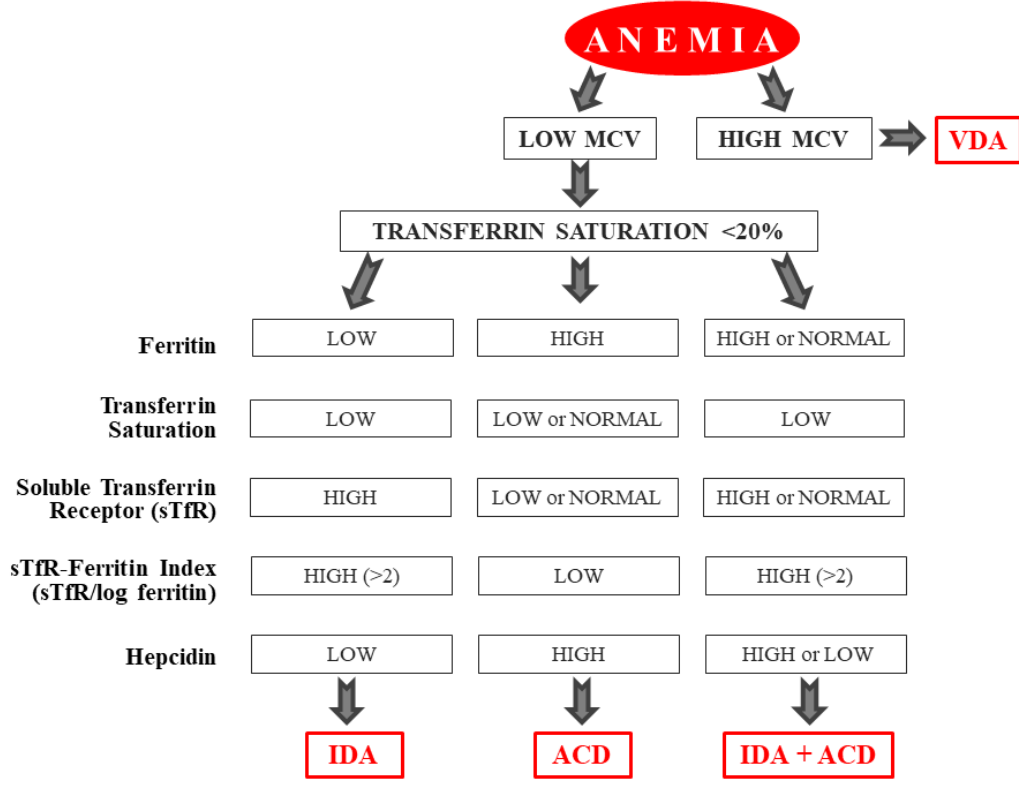
Figure 2. Characteristics of the different types of anemia associated with celiac disease (CD): iron deficiency anemia (IDA), anemia of chronic disease (ACD), and vitamin B 12 and folic acid deficiency anemia (VDA).